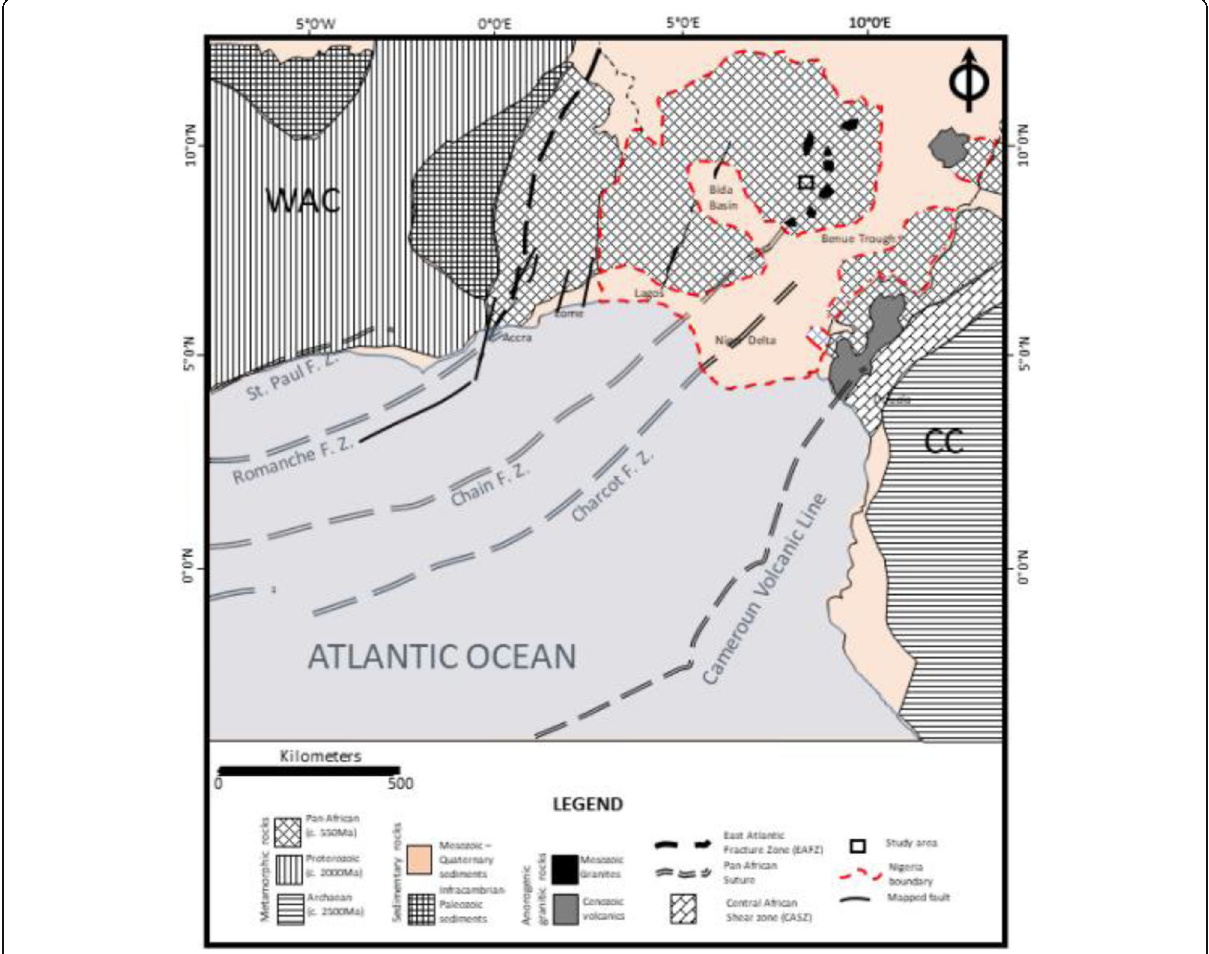
Fig. 2 Generalized geologic map of West Africa showing the position of Nigeria and study area with the North Atlantic and other Fracture Zones Fracture Zones (after Campbell, 2018) to show their relationship of the study